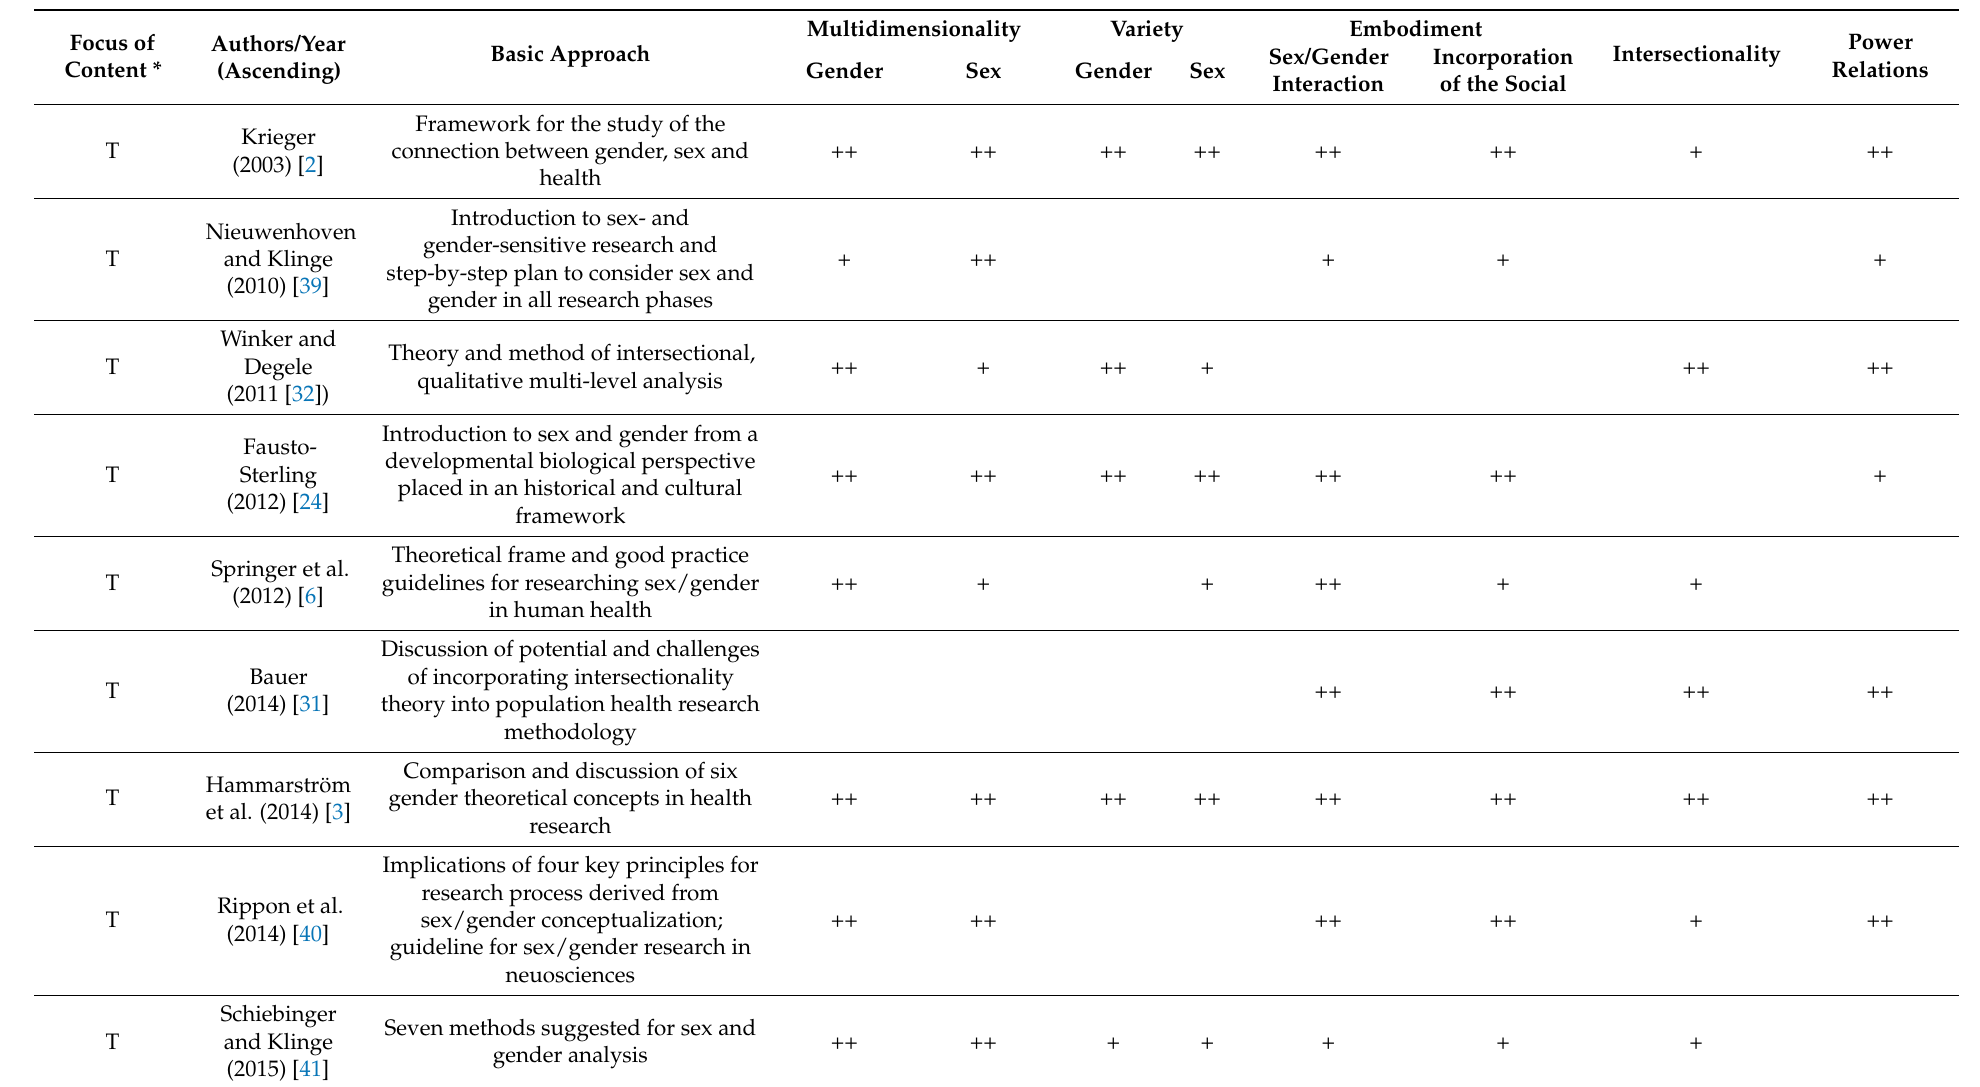
Table 1. Concepts or models of sex- and gender-related dimensions for quantitative